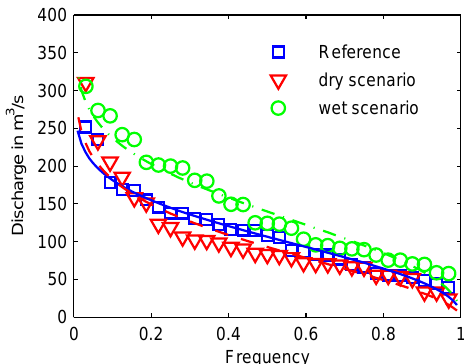
Figure 6. Cumulative frequency distribution of flood discharges in Chaudfontaine (lower reach) in the present situation and in the time period 2070–2100. Discrete points are results from discharge time series obtained from the hydraulic model WOLF1-D and curves correspond to fitted Weibull